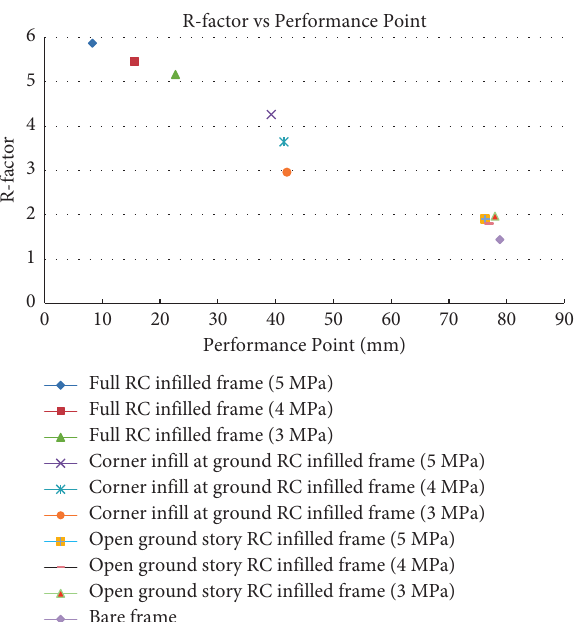
Figure 10: R factor versus performance point graph for all structural models.